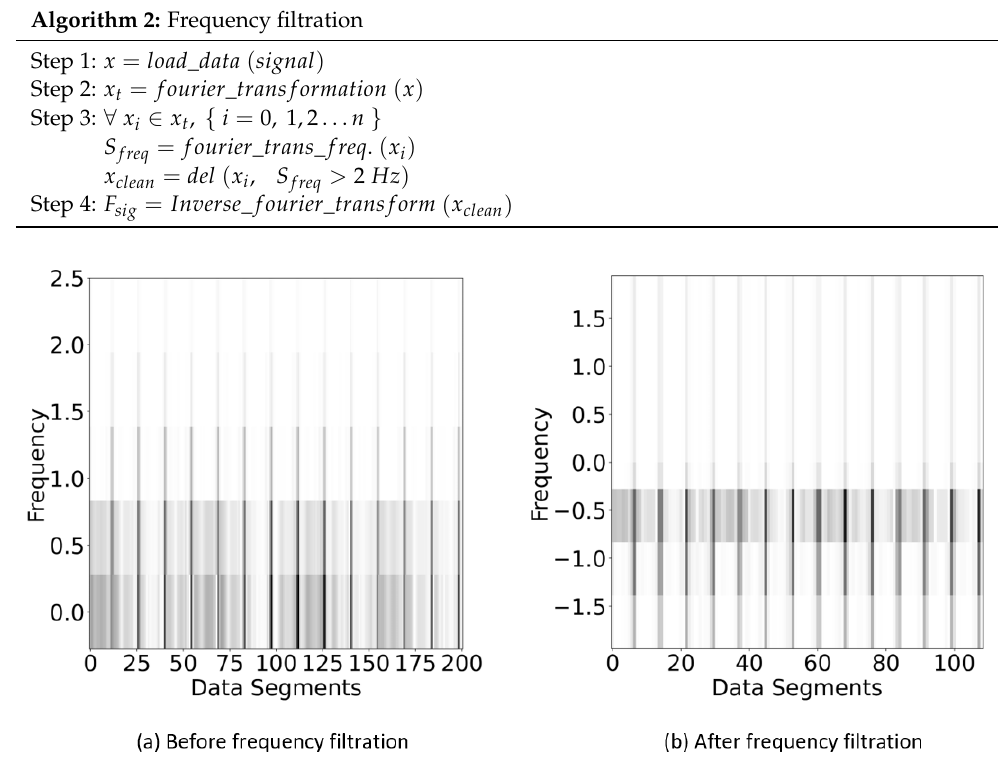
Figure 3. ( a ) Spectrogram before frequency filtration: x -axis (data segments), y -axis (frequency in Hz), ( b ) spectrogram after frequency filtration: x -axis (data segments), y -axis (frequency in Hz).